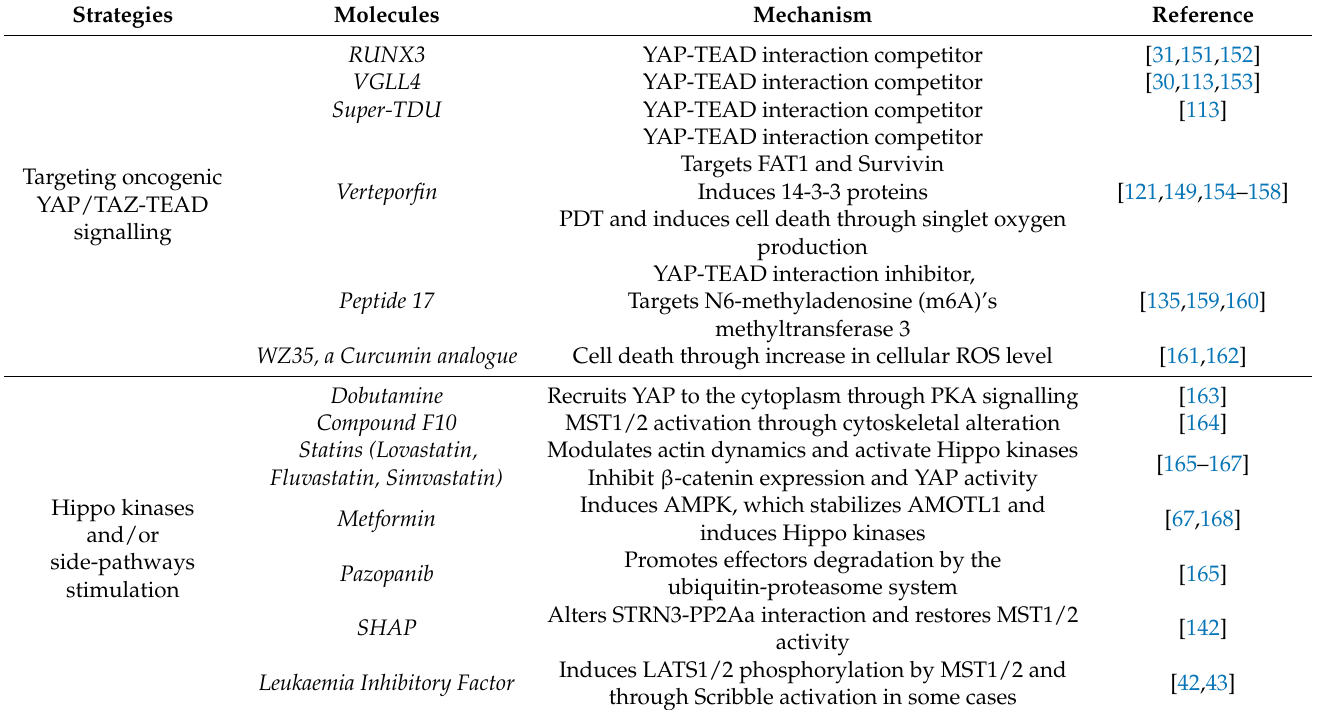
Table 2. Recapitulation of potential anti-GC molecules targeting the Hippo